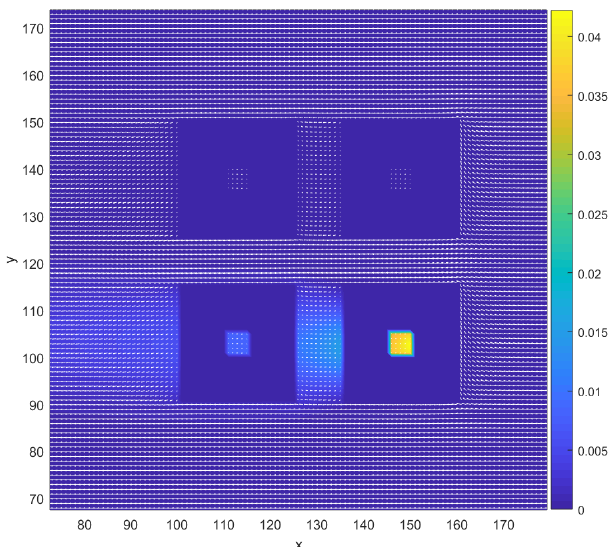
Fig. 2. Horizontal field of nondimensional CO concentration C/C 0 at the roof level (wind comes from the right).